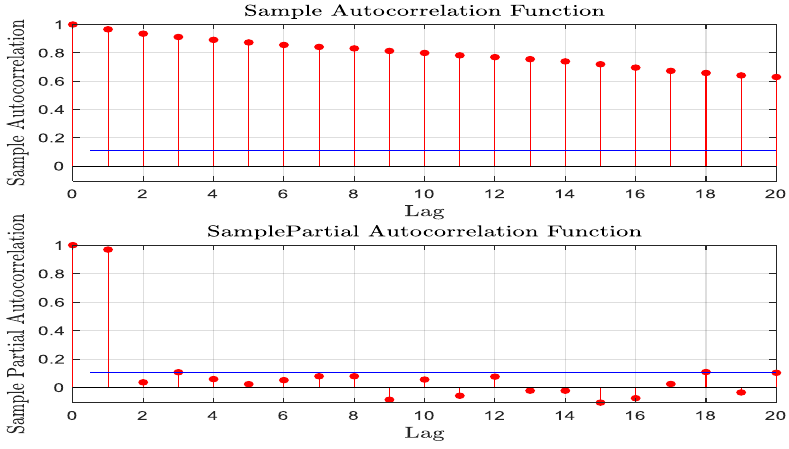
Figure 11. The auto-correlation function and partial correlation function of wind speed series.